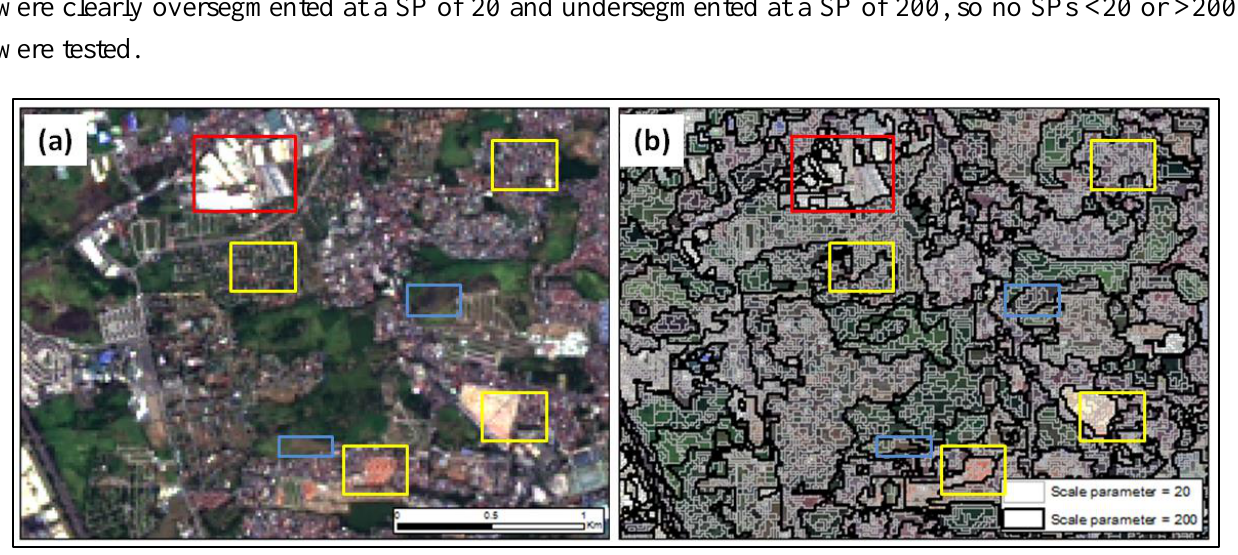
Figure 2. ( a ) Subset of the study area image. ( b ) segmentation with excessive oversegmentation (gray lines) and excessive undersegmentation (black lines) of residential areas. The yellow boxes show some examples of residential areas with different spectral properties. The red box (industrial area) and blue boxes (bare soil areas) show land use/land cover types with high spectral similarity to residential